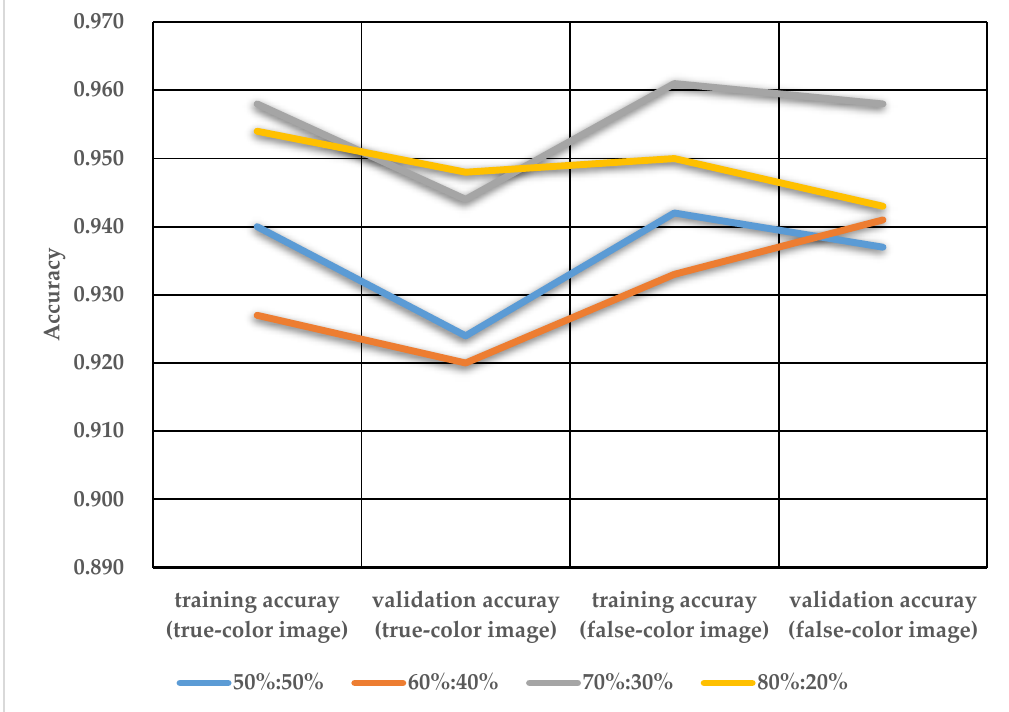
Figure 8. Training and validation accuracies of the true-color image and false-color image under four different ratios of training and validation samples.